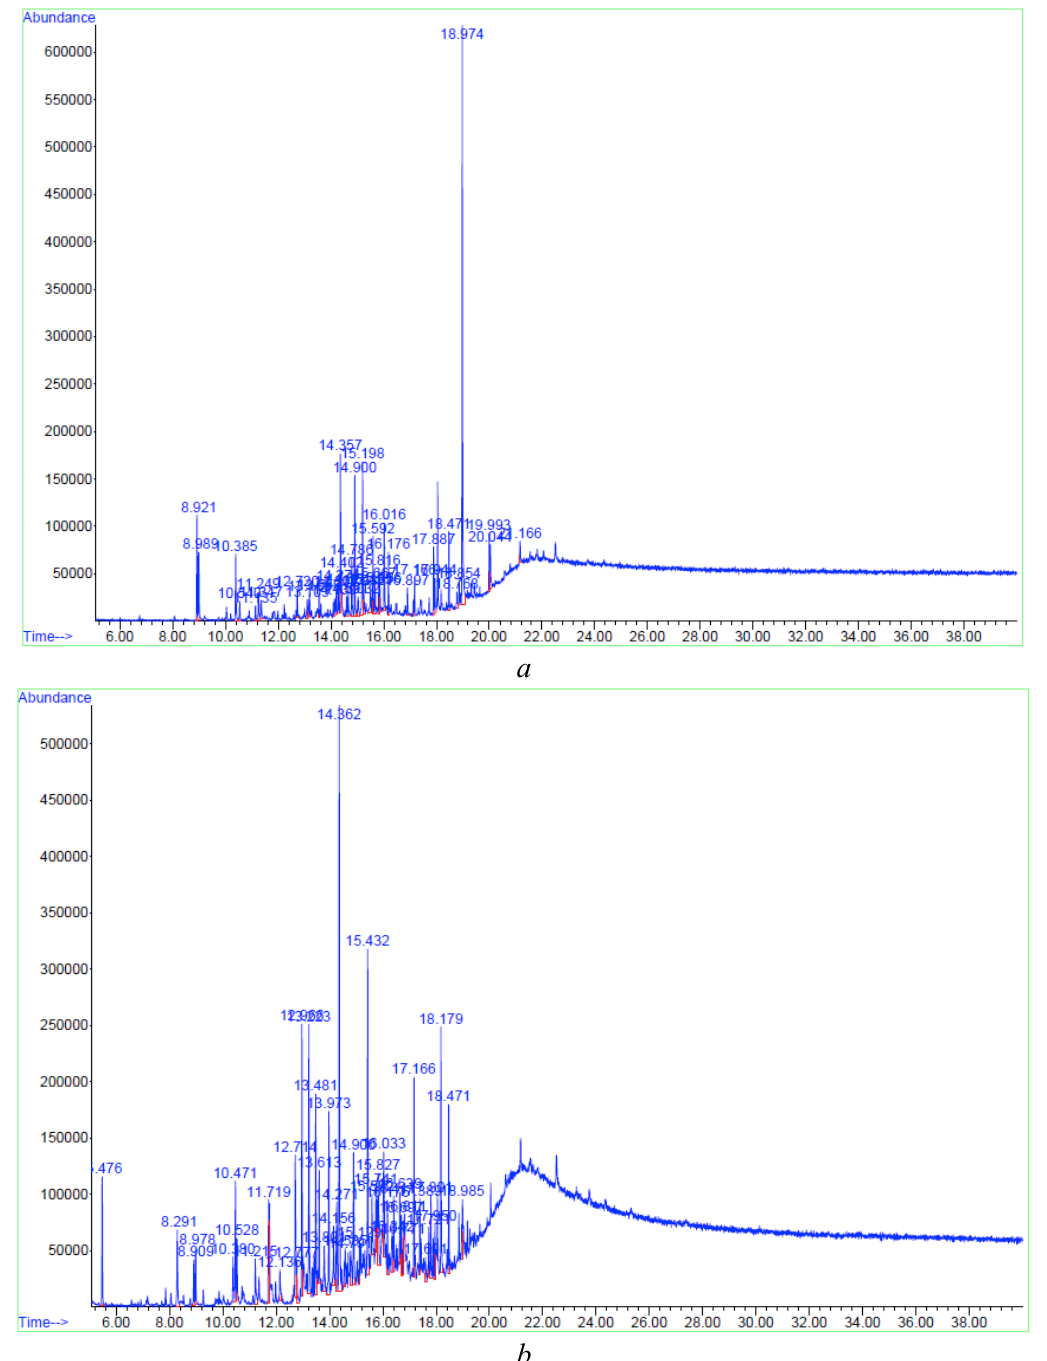
Fig. S3: GS-MS chromatogram of leaves ( a ) and fruits ( b ) of essential oil of F. viridis Weston from sample III